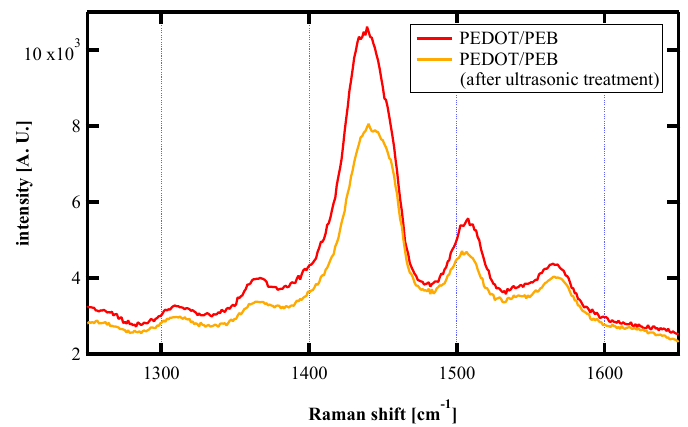
Figure 5. Raman spectra of the PEDOT/PEB sample before and after ultrasonic treatment.